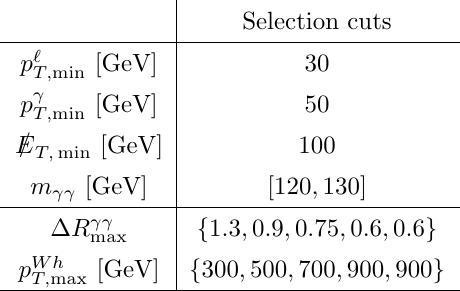
bin, see section 3.2 for the de(cid:12)nition T